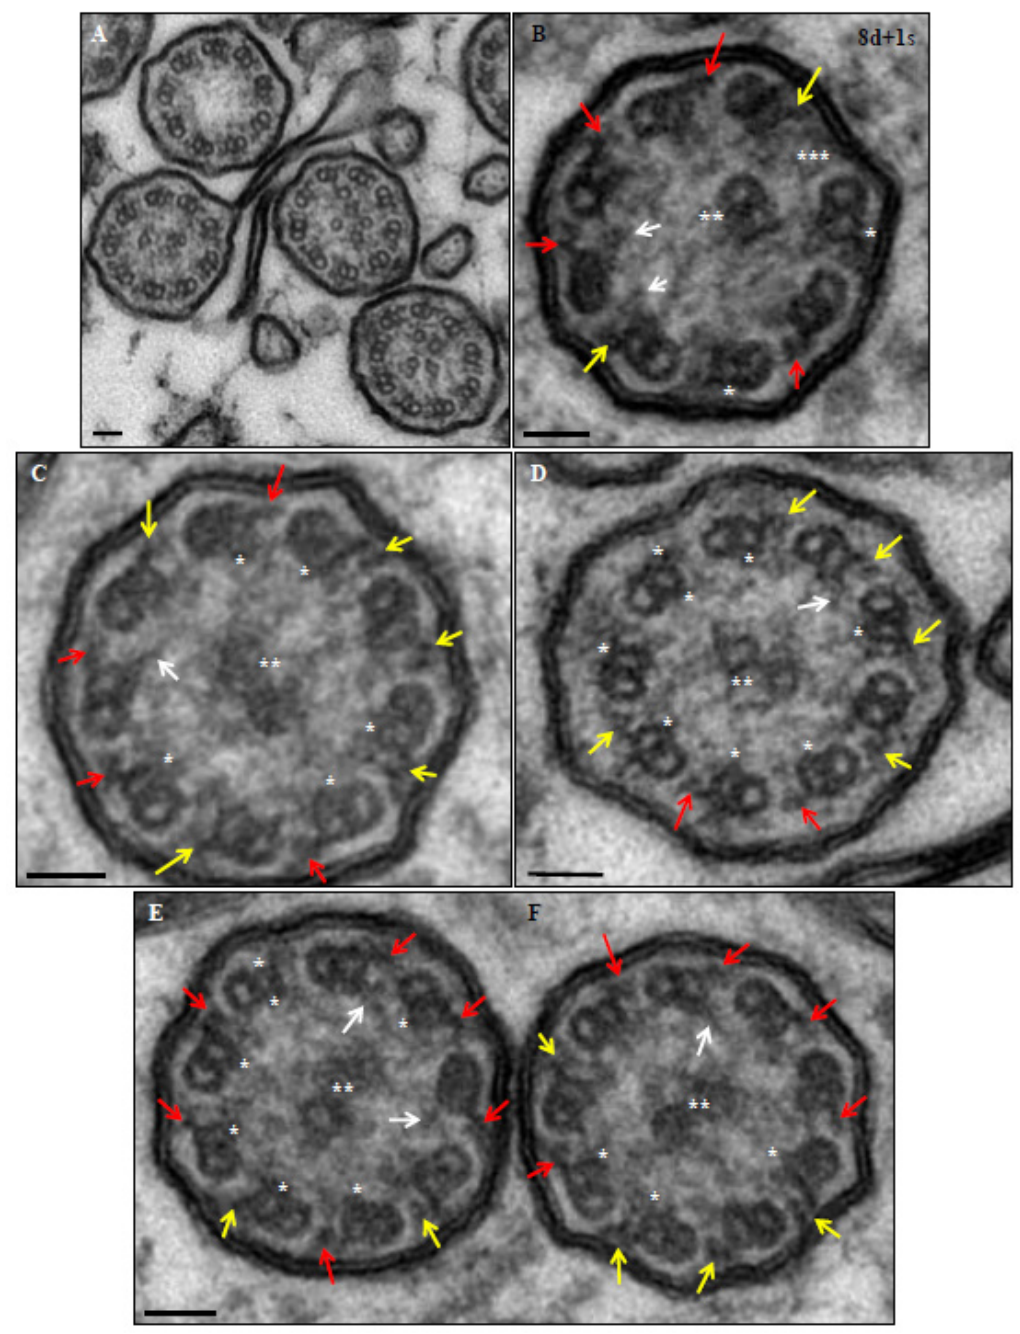
Figure 4. Ultrastructural images of axonemes from patient 15. Normal outer dynein arms (red); decreased dimensions or poor definition of outer dynein arms (yellow); normal inner dynein arms (white arrows); absence of dynein arms (*); absence, decreased dimensions or poor definition of the central pair microtubules (**); and absence of a peripheral microtubule doublet (***). ( A ) Axonemes with disruption of the central pair complex. ( B ) Case with absent, decreased dimensions or poor definition of 5 outer and 7 inner dynein arms (abnormal axoneme). ( C ) Case with absent, decreased dimensions or poor definition of 5 outer and 5 inner dynein arms (abnormal axoneme). ( D ) Case with absent, decreased dimensions or poor definition of 7 outer and 6 inner dynein arms (abnormal axoneme). ( E ) Case with absent, decreased dimensions or poor definition of 3 outer and 6 inner dynein arms (normal axoneme). ( F ) Case with absent, decreased dimensions or poor definition of 4 outer and 3 inner dynein arms (normal axoneme). Bars: 50